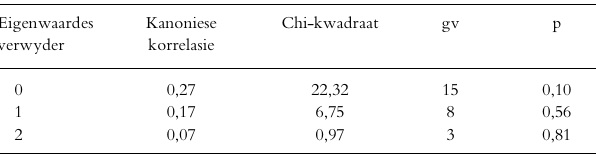
TABEL 8 CHI-KWADRAATTOETSEVIR DIE BEDUIDENDHEIDVAN